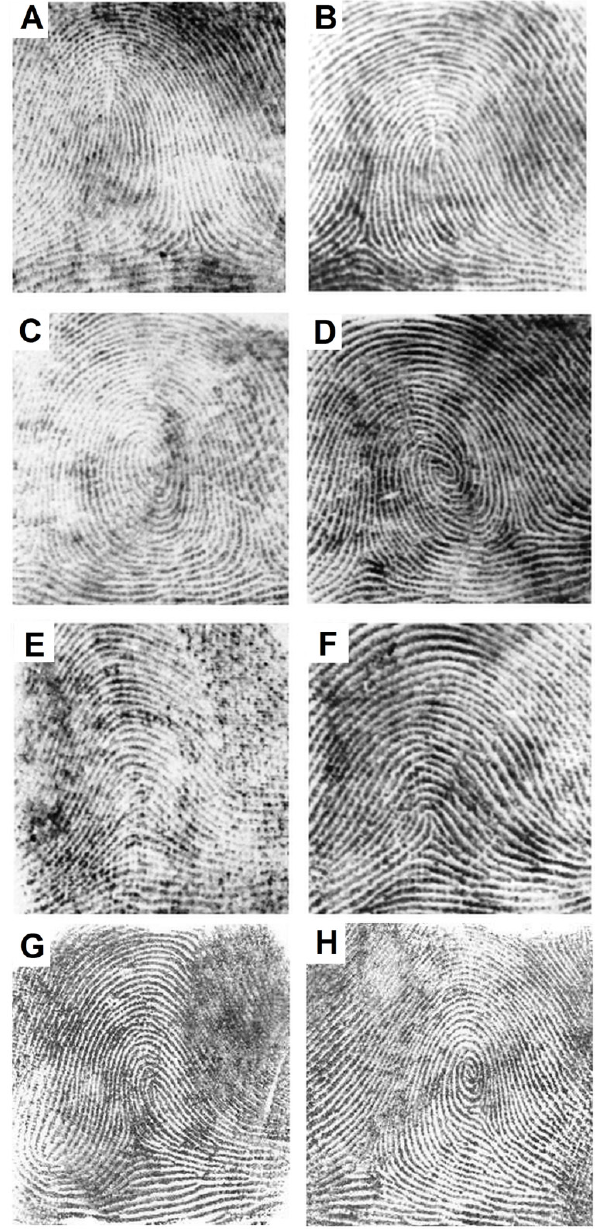
Figure 2. Different types of fingerprints. A : Ulnar loop, B : Radial loop, C : Plain Whorl, D : Double loop whorl, E : Plain arch, F : Tented arch, G : Accidental whorl, H : Central pocket